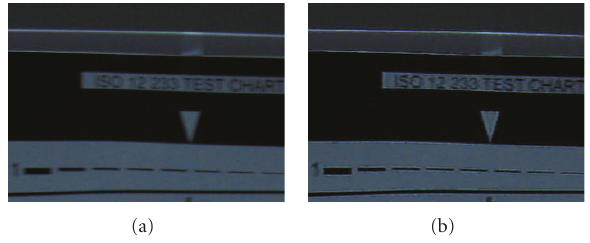
Figure 13: Restoration results of real-blurred image. (a) Test image. (b) Restoration result of the proposed method, where the final PSF is achieved after 27